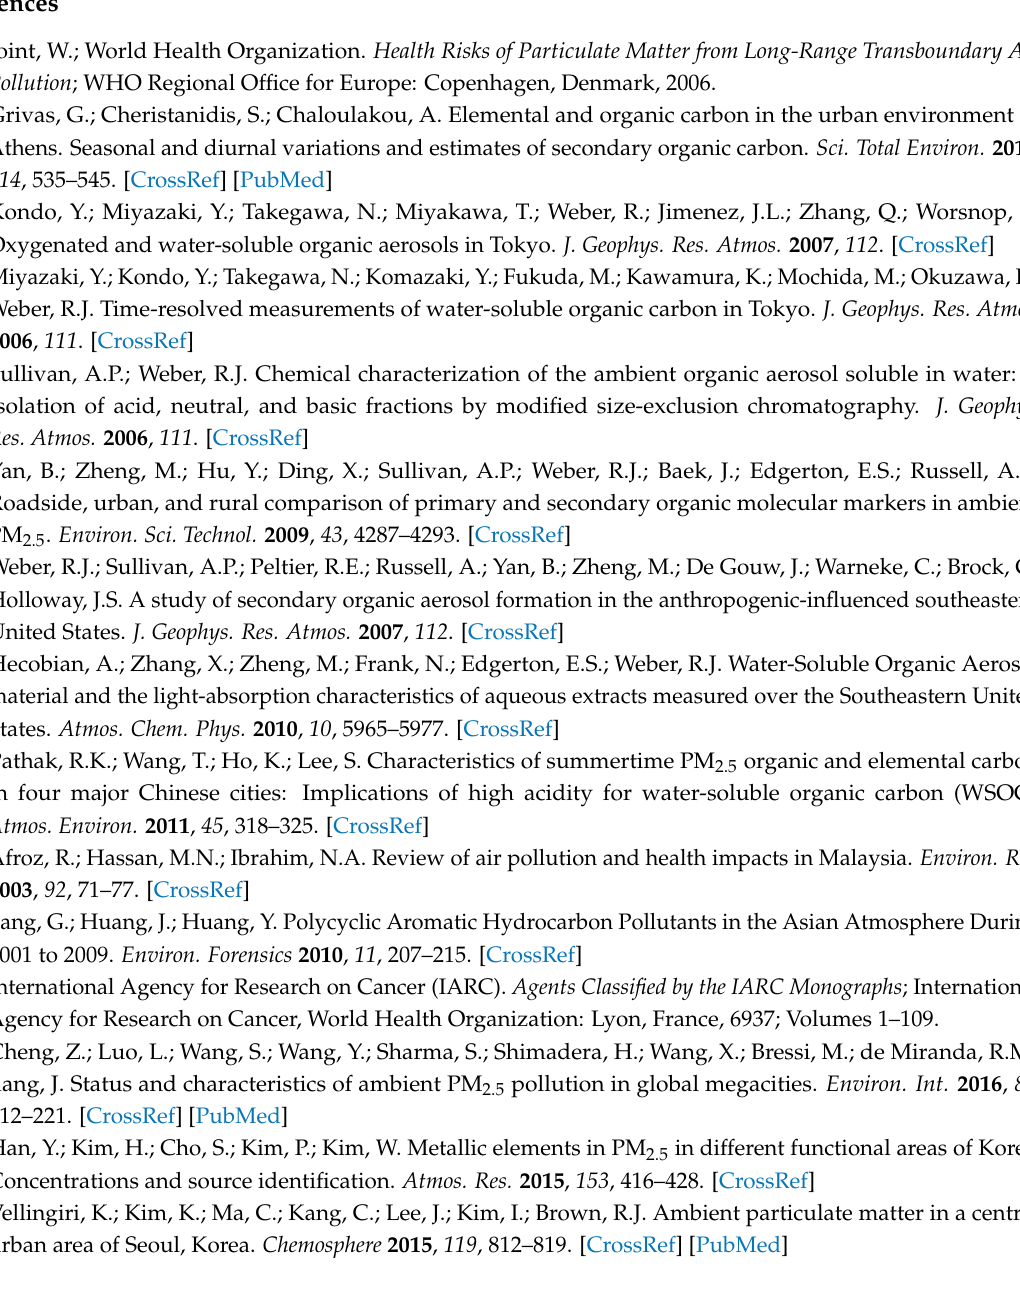
Figure S1: Deming regression analysis of organic carbon (OC) and elemental carbon (EC) in each